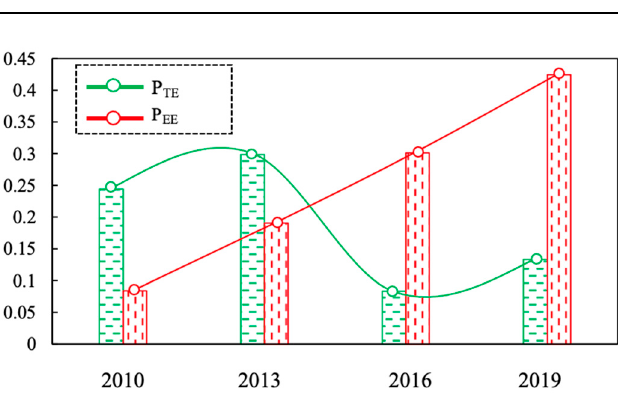
Figure 2. Comprehensive development index of tourism economy and eco ‐